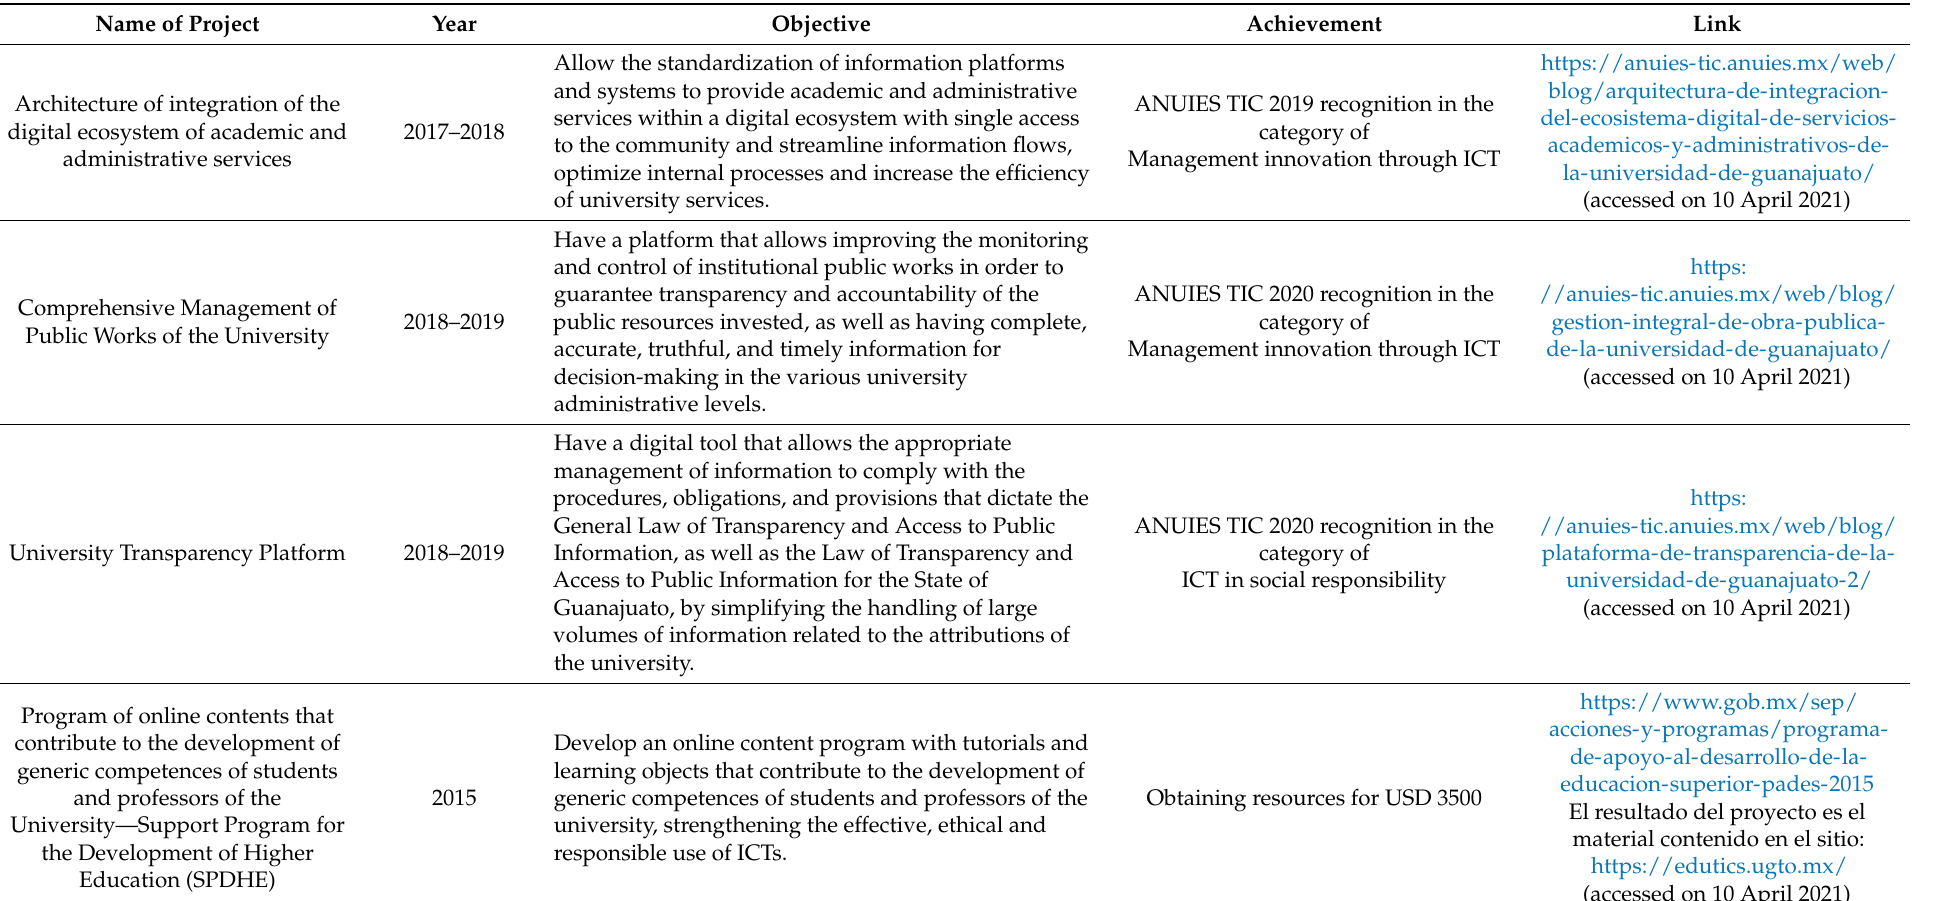
Table 7. Actions and achievements obtained by the University of